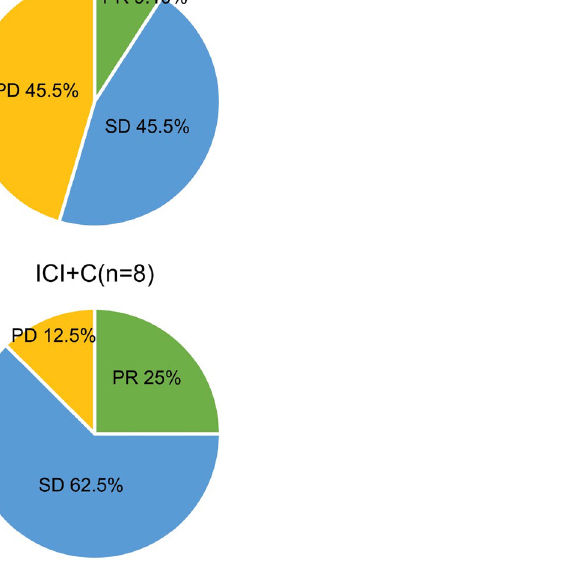
Figure 1. Treatment response to ICI and ICI +